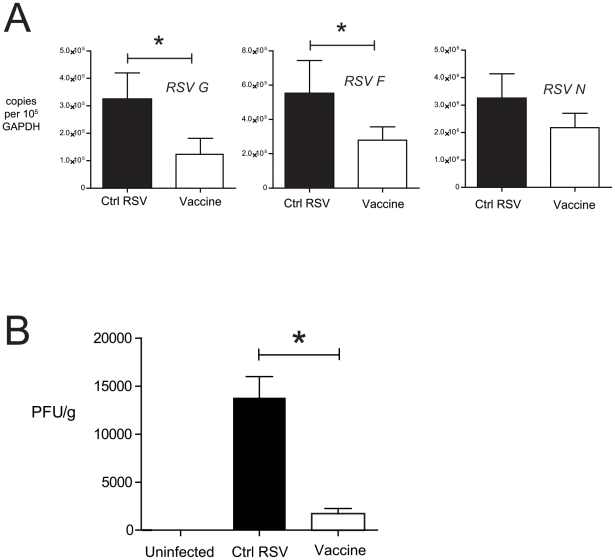
NE-RSV immunization promotes clearance of RSV from the lungs.Mice were immunized (i.n.) as previously described, and challenged oropharyngeally (o.p) with 105 PFU live RSV at day 56. In (A), the expression of viral transcripts in the lungs (day 4 post-infection) was assessed via QPCR. In (B), viral titers were determined at day 4 post-challenge from homogenized lung samples via plaque assay.